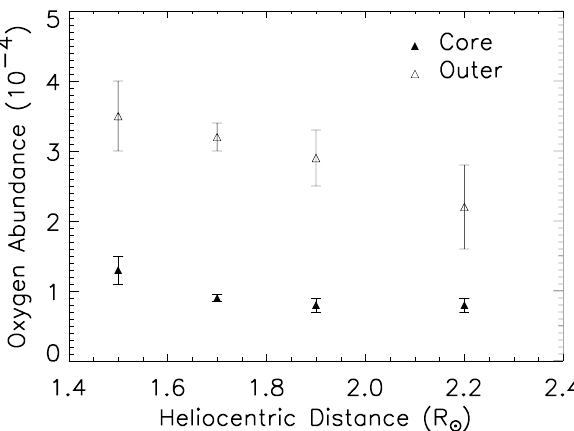
Fig. 7. Oxygen abundance relative to hydrogen as a function of heliodistance in the streamer core and lateral structures, denoted with full and open triangles, respectively. The values are averages of the results obtained with the ratio of the radiative and collisional